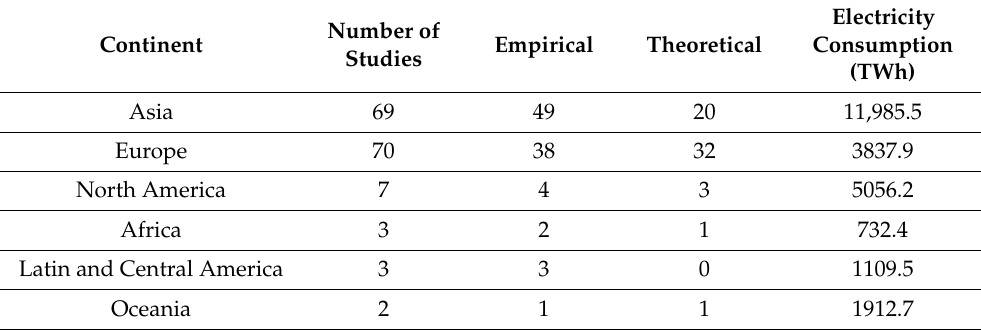
Table 4. Number of publications by continent, methodology, and energy consumption.